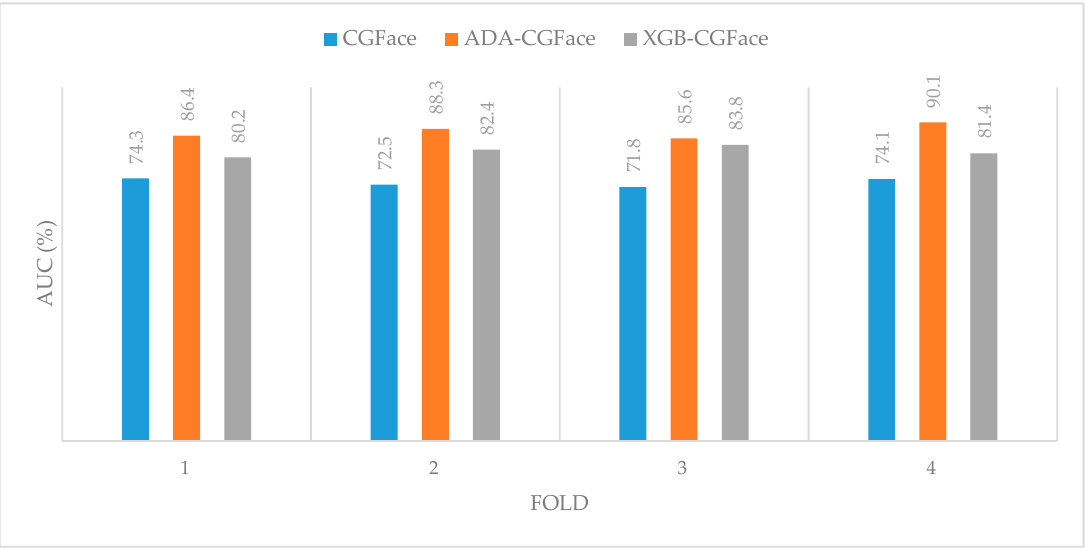
Figure 9. A comparison regarding AUC for various methods through 4 folds on the imbalanced environment (No. CG images / No. real images = 1/10).